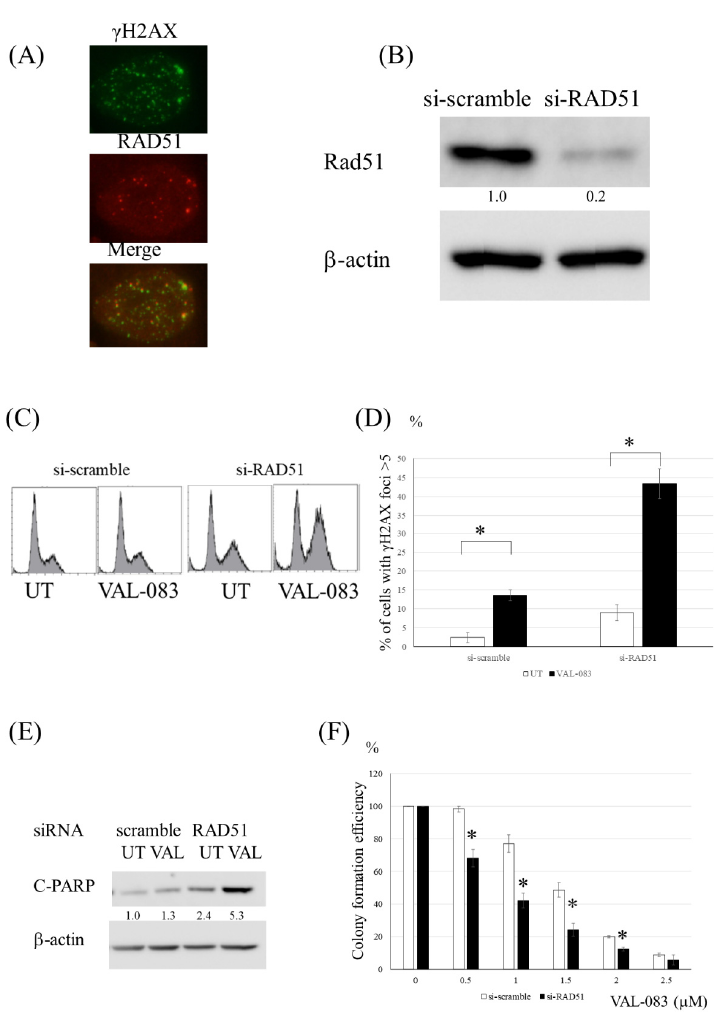
Figure 7. Inhibition of HR enhanced the cytotoxicity induced by DAG in TMZ-resistant glioma cells. ( A ) Immunofluorescence analysis of the physical coincidence of γ -H2AX and RAD51 foci in U251TMZR#8 cells treated with VAL-083. ( B ) Western blot analysis of RAD51 and β -actin levels in U251TMZR#8 cells following exposure to scramble or RAD51-targeting siRNA. ( C ) Fluorescence-activated cell sorting (FACS) analysis of cell cycle distribution in control and RAD51-suppressed U251TMZR #8 cells 2 days after VAL-083 (1 µ M) exposure. ( D ) Quantitative data from immunofluorescence analysis of γ -H2AX foci in control and RAD51-suppressed U251TMZR#8 cells treated with VAL-083. ( E ) Western blot analysis of cleaved PARP, cleaved caspase 3, and β -actin levels in control and RAD51-suppressed U251TMZR#8 cells treated with VAL-083. ( F ) Colony formation efficiency of control and RAD51-suppressed U251TMZR#8 cells studied following VAL-083 exposure (0–2.5 μ M, 4 days)., * p < 0.05.